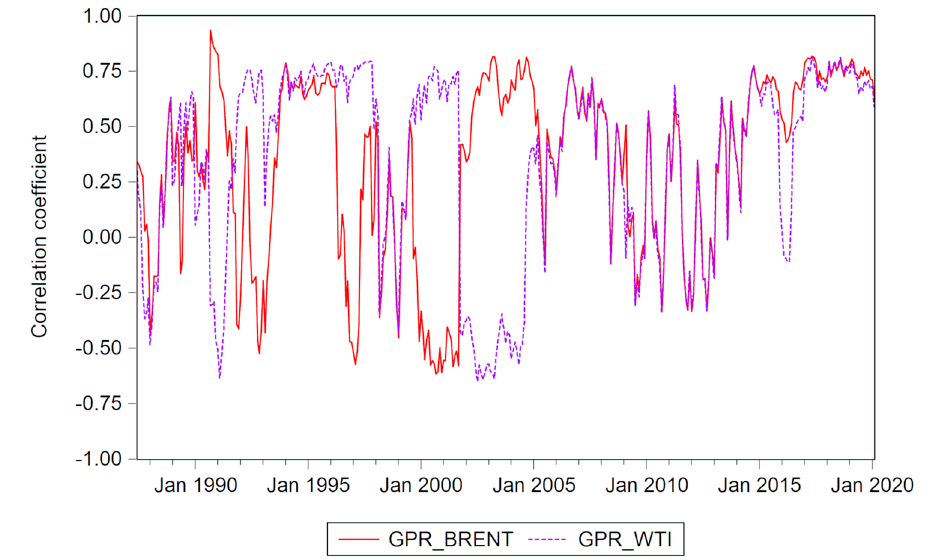
Figure 3. Dynamic conditional correlations (DCC) between the GPR index and crude oil prices. Note: GPR_BRENT and GPR_WTI represent the dynamic conditional correlations of the GPR-Brent pair and GPR-WTI pair, respectively. The sample period is from June 1987 to February 2020. Energies 2020 , 13 , 4277 10 of 20